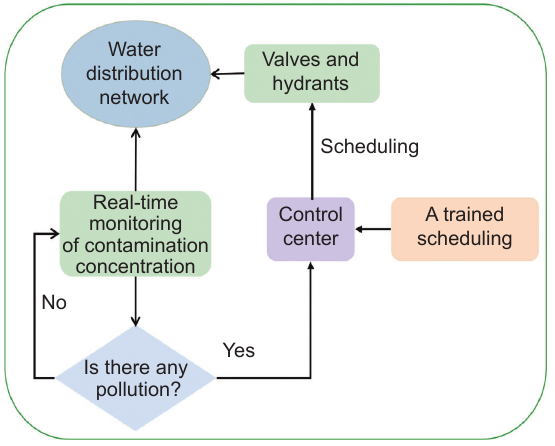
Fig. 1 System architectures of emergency response in a